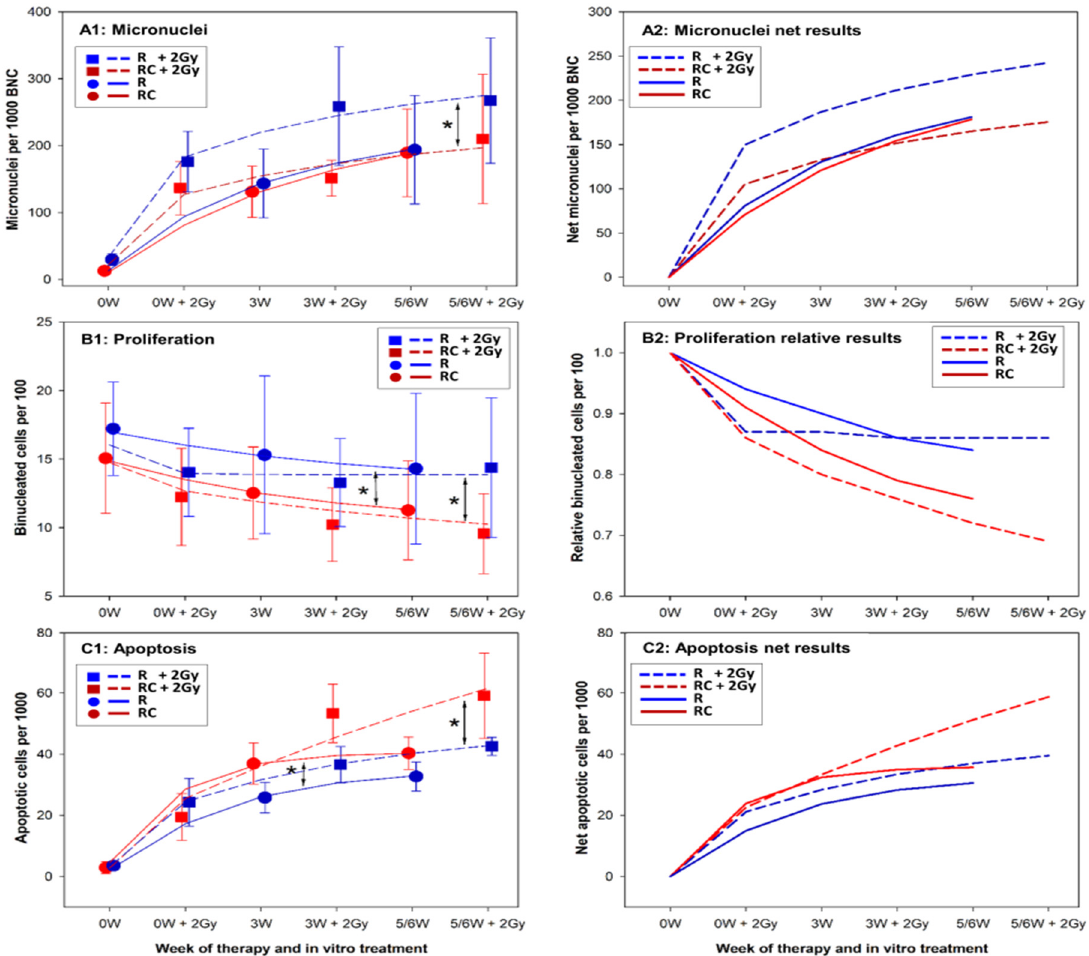
Figure 5. Mean results for RC and R patients. ( A ) panels: micronucleus frequencies, ( B ) panels: proliferation marker, ( C ) panels: apoptosis levels. Right panels (marked 2) show the net or relative fits to facilitate following the kinetics of response. Round symbols and solid lines demonstrate the effect of therapy alone. Square symbols and dashed lines demonstrate the effect of therapy plus 2 Gy ex vivo irradiation. RC: patients receiving radiotherapy + chemotherapy; R: patients receiving radiotherapy alone; W: week of treatment. Asterisks indicate significant differences between the respective curves.